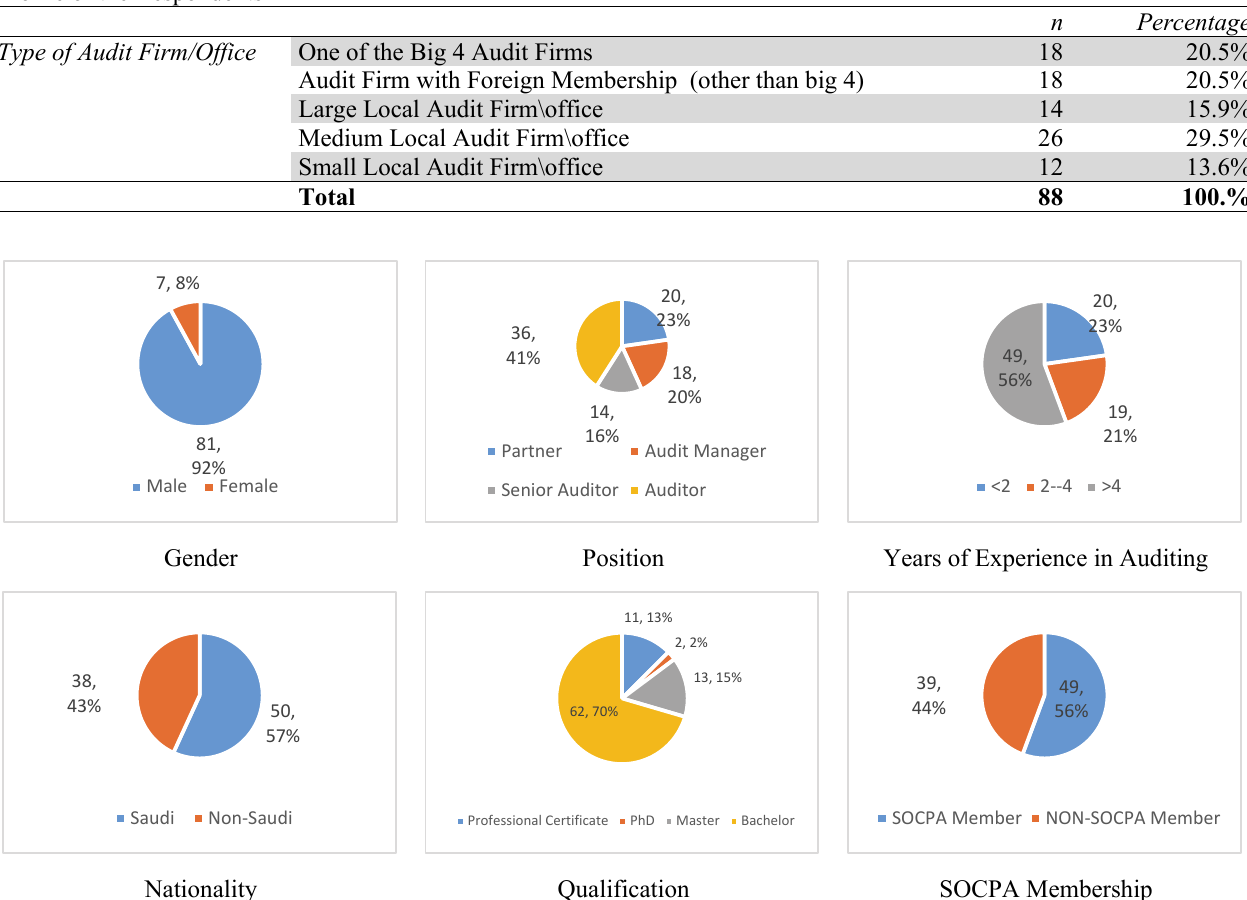
Fig. 1. Personal characteristics of the